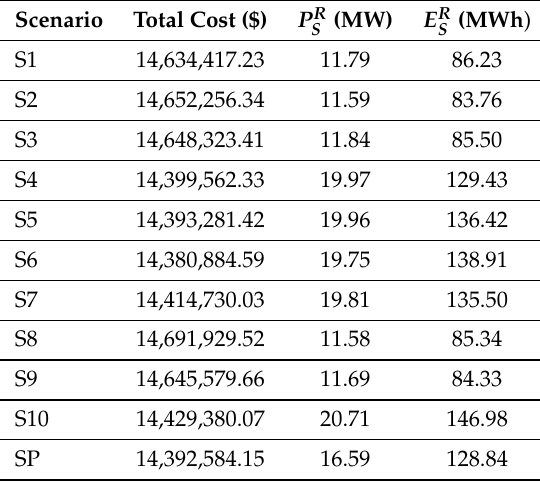
Table 6. Results of all scenarios solved